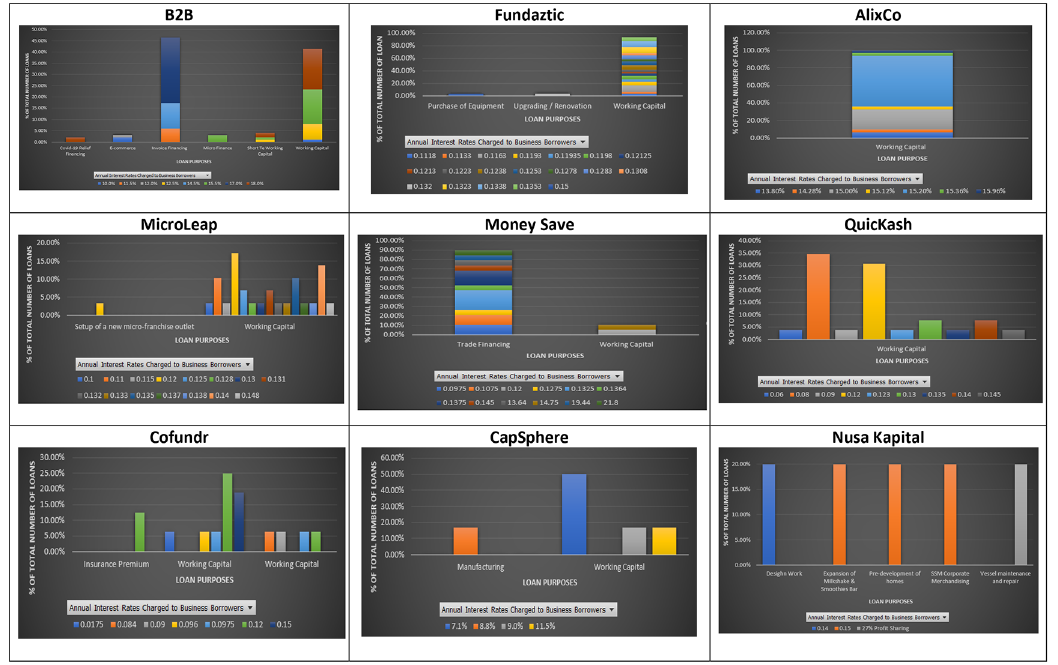
Figure 2. Interest rates and loan purposes at nine P2P lending